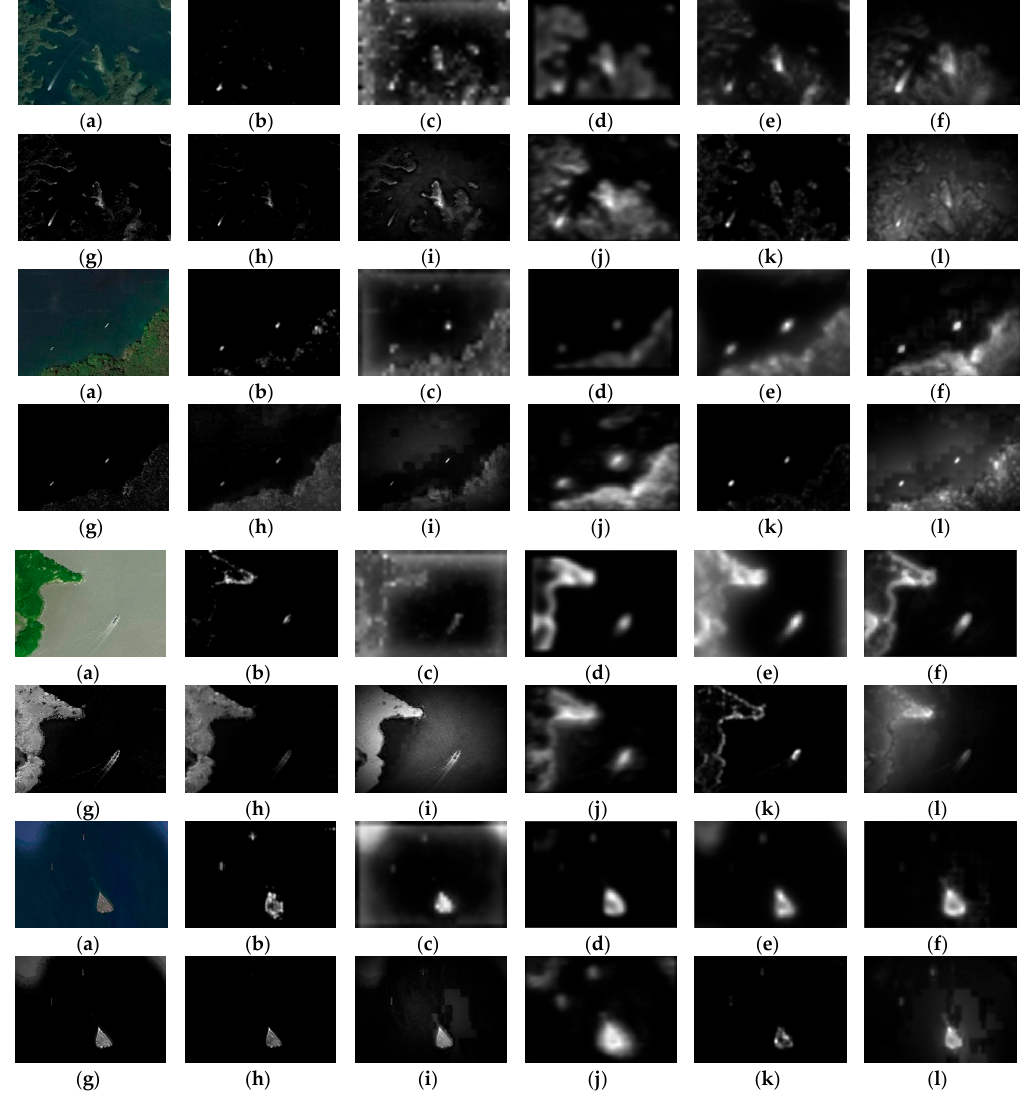
Figure 12. Visual comparison of the saliency maps: ( a ) input image; ( b ) WGS; ( c ) ITTI; ( d ) AIM; ( e ) GBVS; ( f ) CA; ( g ) LC; ( h ) MSSS; ( i ) SDSP; ( j ) RARE; ( k ) SR; and ( l ) Nevrez.